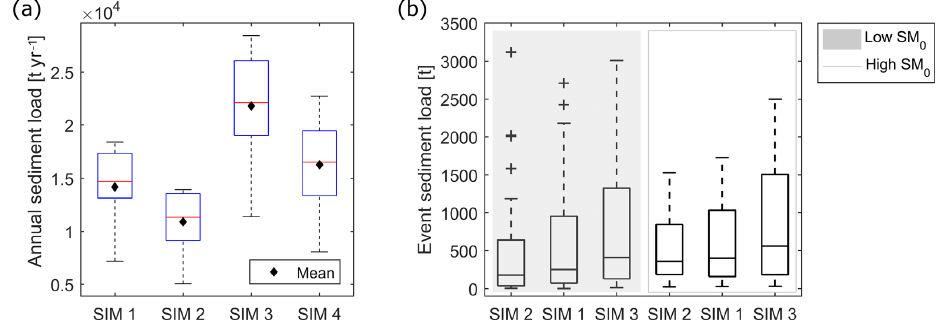
Figure 10. (a) Boxplots of annual sediment load and their mean values at the outlet of the catchment in the four simulation experiments; (b) boxplots of event sediment loads divided into low and high initial soil moisture conditions. The boxplots compare the effect of the spatial variability in precipitation and surface erodibility on events with different initial soil